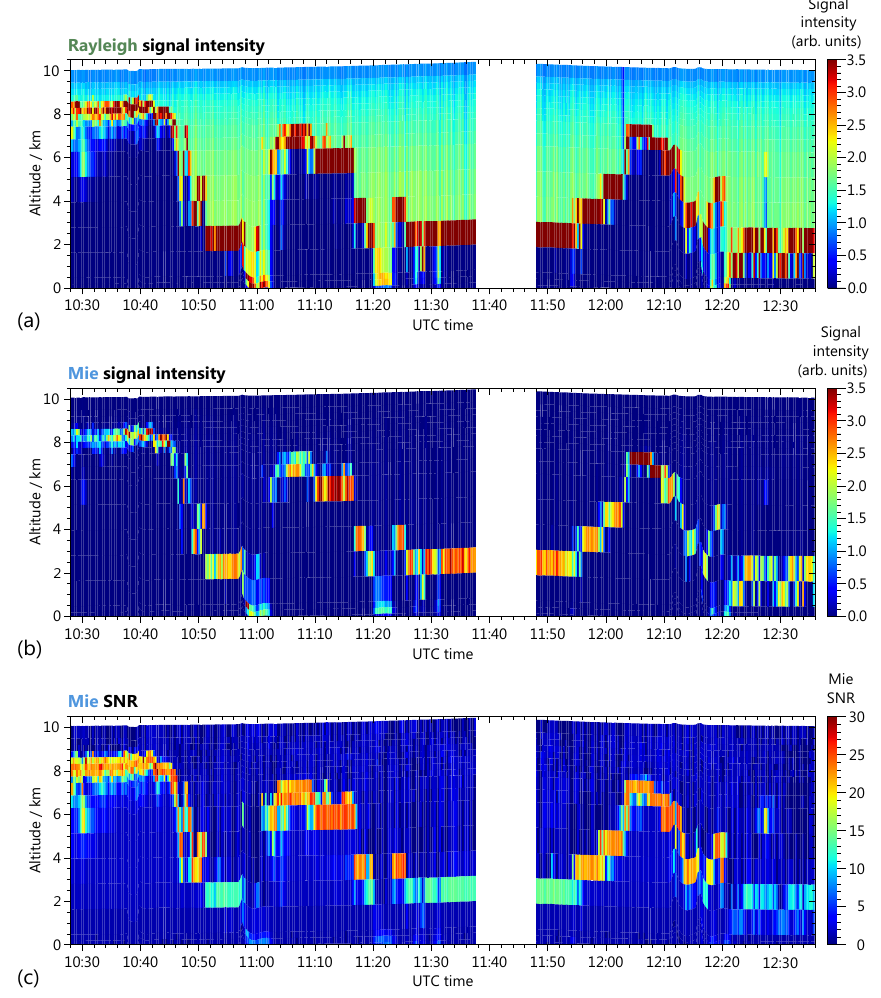
Figure 6. Signal intensities measured for (a) the A2D Rayleigh channel and (b) the A2D Mie channel during the flight on 27 September 2016 between 10:28 and 12:36UTC. The intensities are range-corrected and scaled to the integration time of the respective range gates. The background and detection chain offset were subtracted. For the Mie channel, the Rayleigh background signal was subtracted as explained in the text. The detection of the Rayleigh background signal was performed between 11:41 and 11:47UTC, leading to a data gap in this period. (c) Mie SNR calculated according to Eq. (3.29) in Marksteiner (2013). Bins with signal intensities exceeding the maximum of the respective colour scale are printed in dark